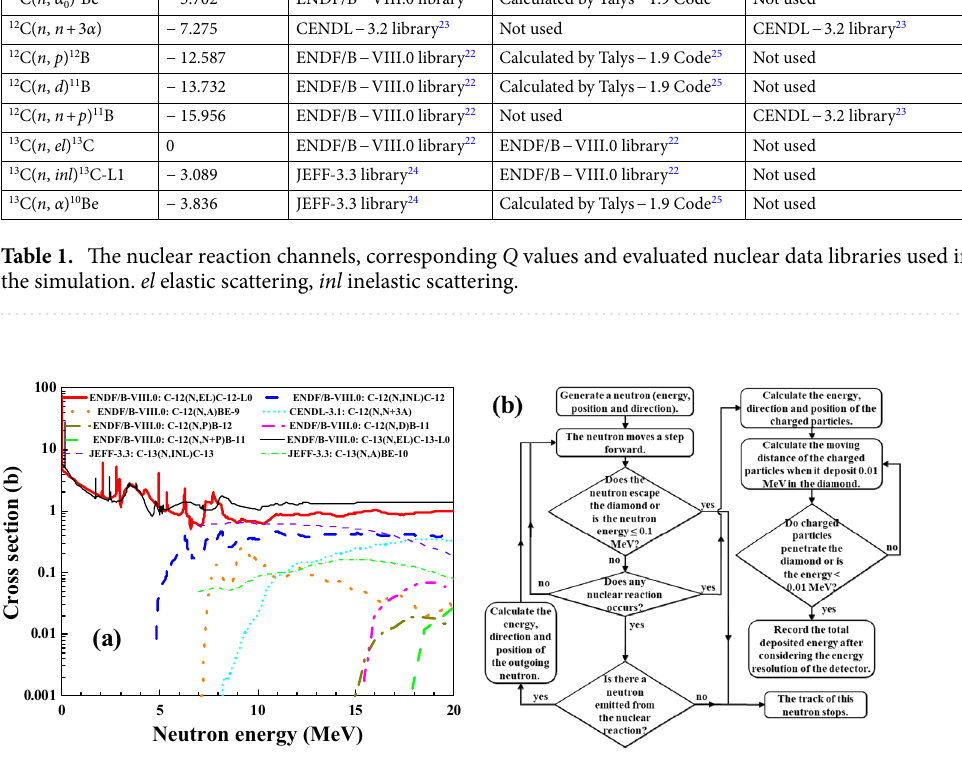
Figure 1. ( a ) The excitation functions of neutron induced reactions on 12 C and 13 C in the energy region from 1 to 20 MeV. ( b ) The flow diagram of the simulation of the response matrix of the diamond